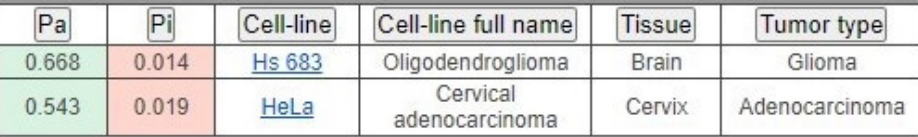
Figure 15. Cancer-cell-line prediction for L1 .